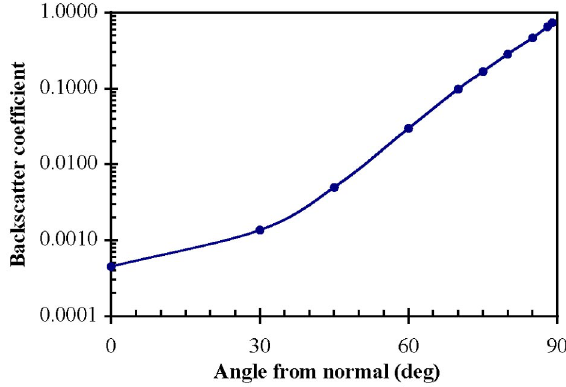
FIG. 3. (Color) Fraction of 1.8 MeV K (cid:6) ions that backscatter off of stainless steel versus angle of incidence, computed by the SRIM code. For angles (cid:13) 45 (cid:1) , the backscatter e -folds in 8.5 (cid:1)